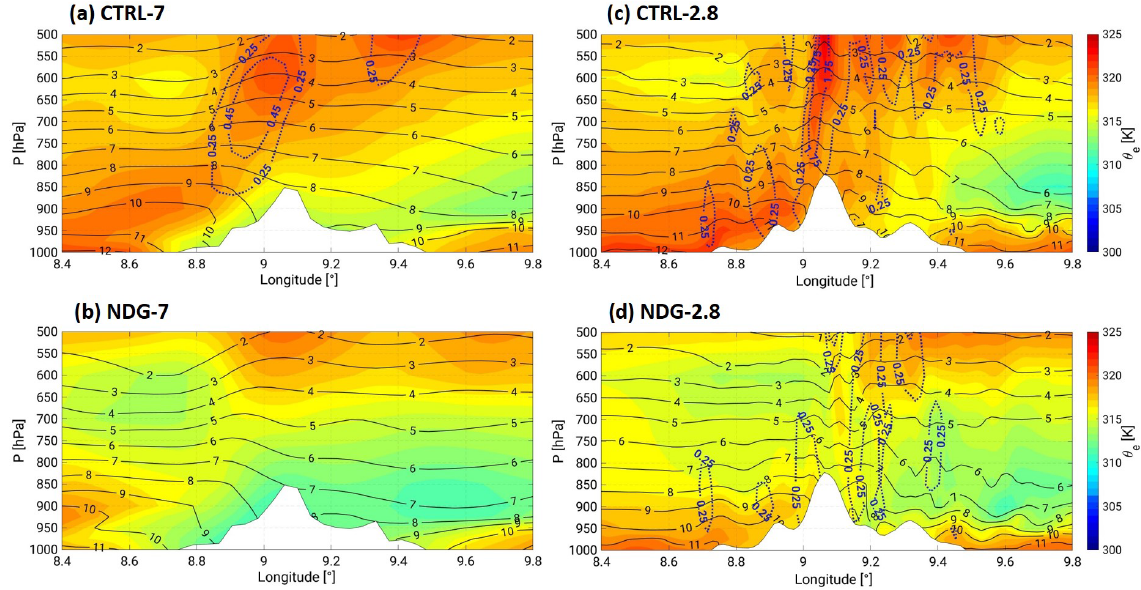
Figure 11. Vertical cross-sections along the mean wind direction between 700 and 1000hPa (see transect in Fig. 1) on 26 October at 17:00UTC. The selected hour corresponds to the first precipitation maximum represented over Corsica by the COSMO-CLM simulations. The position of the transect is represented in Fig. 1. The specific humidity values are represented by black contour lines; the colour shad- ing represents equivalent potential temperature ( θ e ). Vertical wind speed is represented by dashed blue contours, where isolines start at 0.25ms − 1